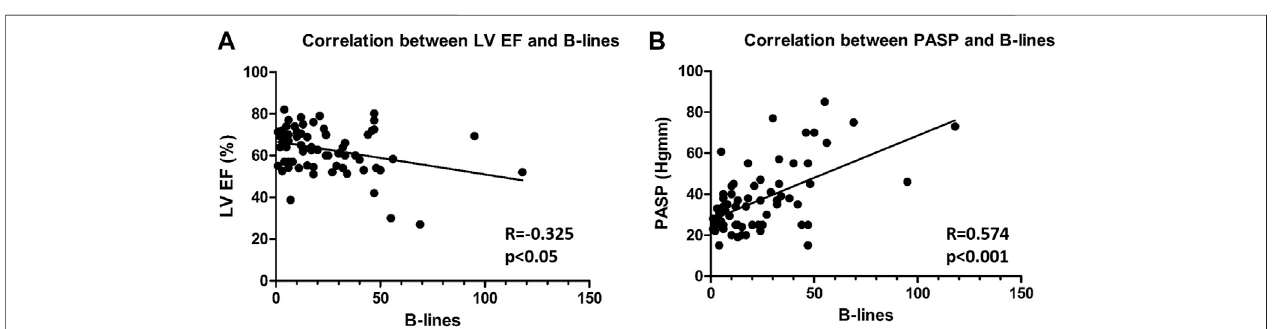
FIGURE 2 | Correlation between B-lines and LVEF (A) and PASP (B) (LVEF: Left ventricular ejection fraction, PASP: Pulmonary arterial systolic pressure).